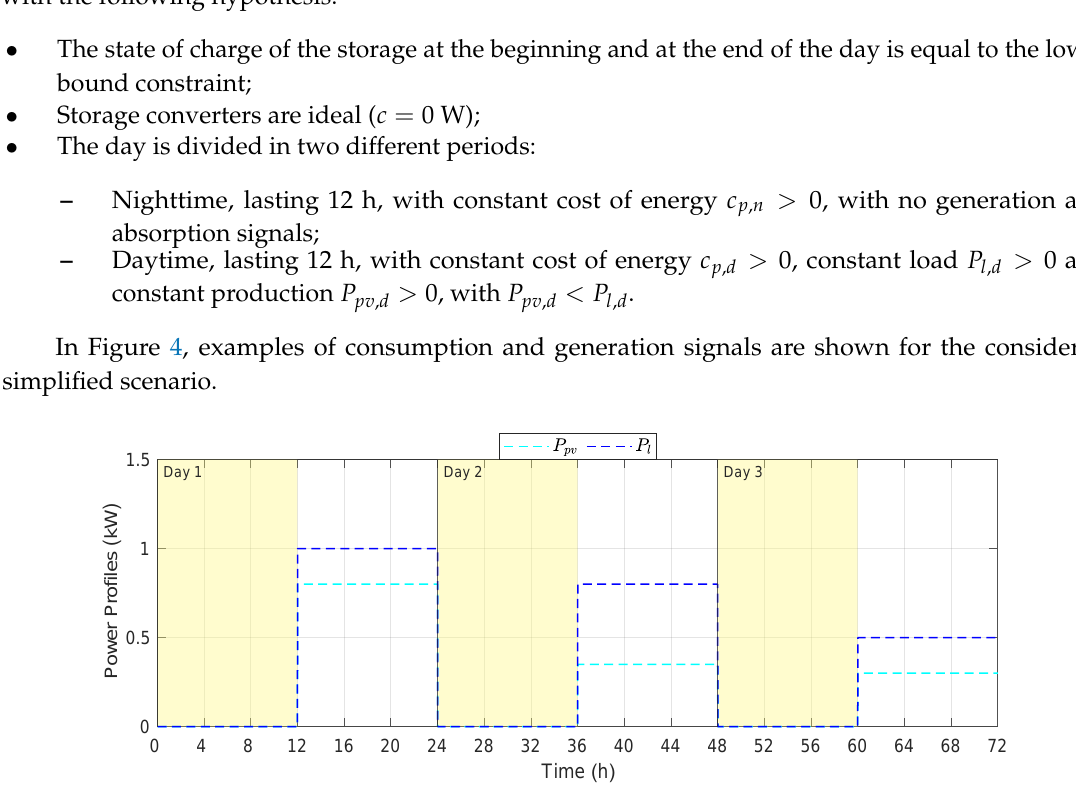
Figure 4. Examples of constant load and photovoltaic power profiles lasting 12 h during daytime; the nighttime period is characterized by a yellow